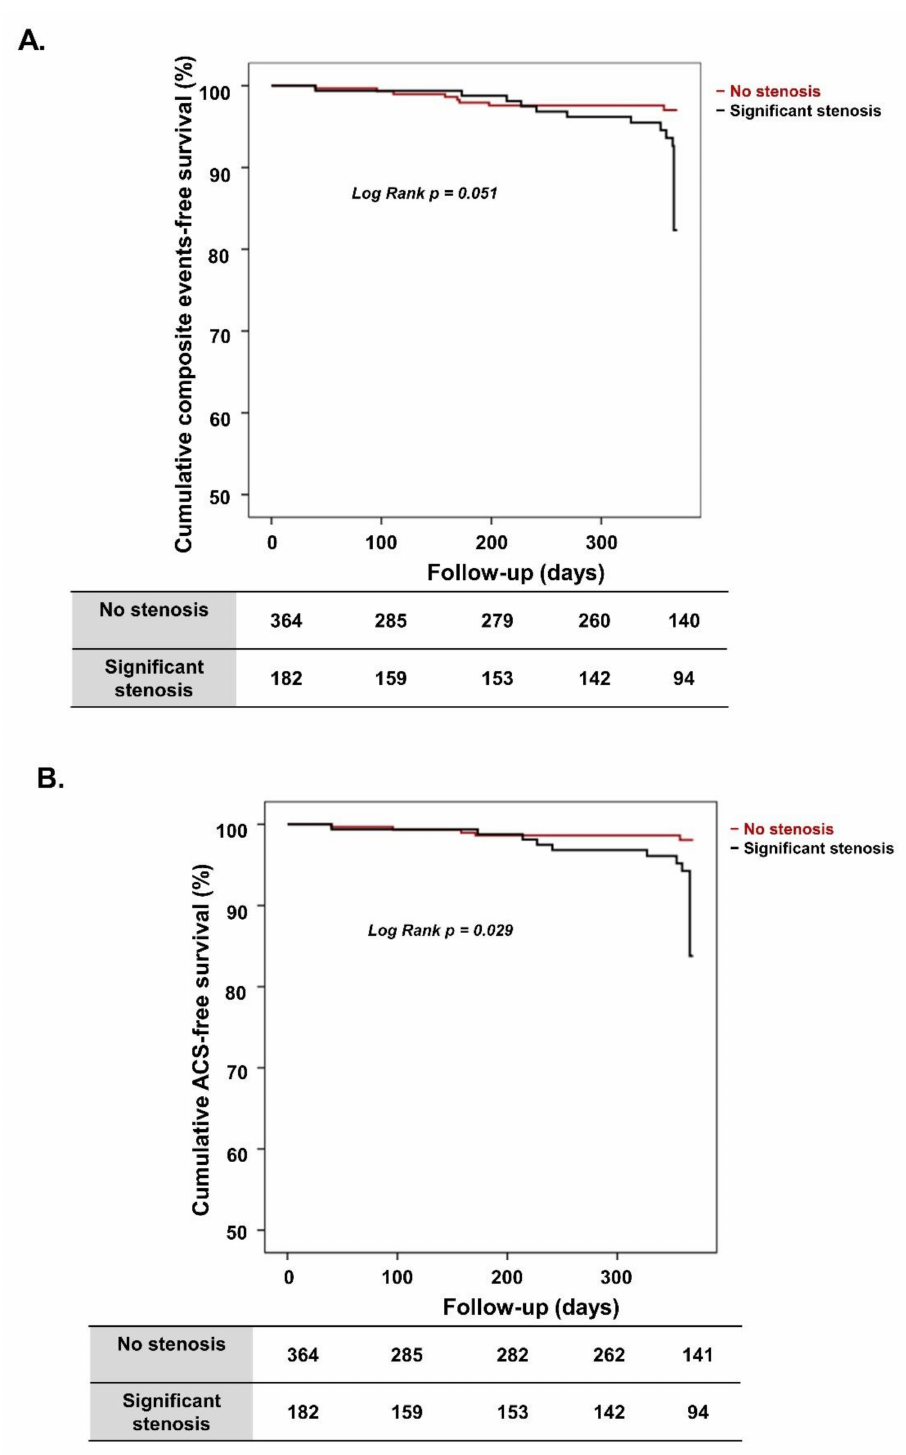
Figure 2. Kaplan–Meier survival curves in propensity score-matched population. ( A ) Cumulative composite event-free survival according to presence of significant stenosis. ( B ) Cumulative ACS-free survival according to presence of significant stenosis. ACS, acute coronary